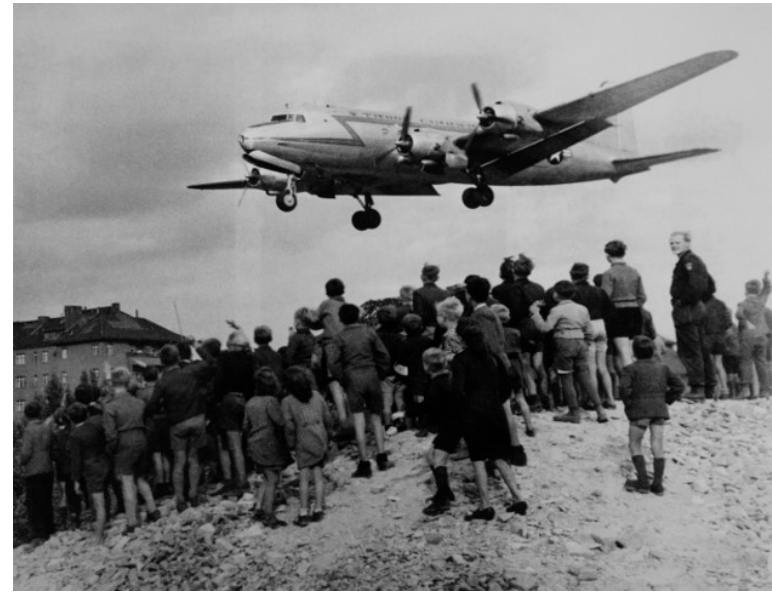
Figure 1. Henry Ries. Landeanflug eines “Rosinenbombers im Templehof Airport” ( Landing Arrival of the Candy Bomber in the Templehof Airport ). 1948. Photograph. © Henry Ries. Deutsches Historisches Museum. Invoice No. 2007/952, file PH009230.